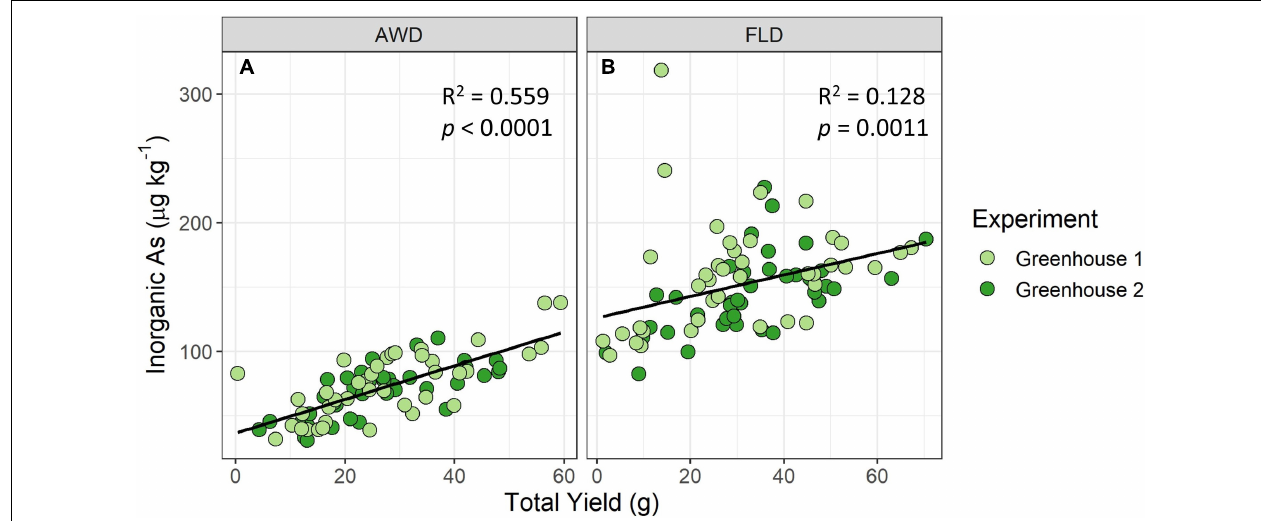
FIGURE 6 | Brown rice inorganic As accumulation vs. total grain yield in greenhouse experiment under AWD20 (AWD) (A) and flood (FLD) (B) treatments. A significant positive correlation is seen between total grain yield and grain inorganic As concentrations in the greenhouses.